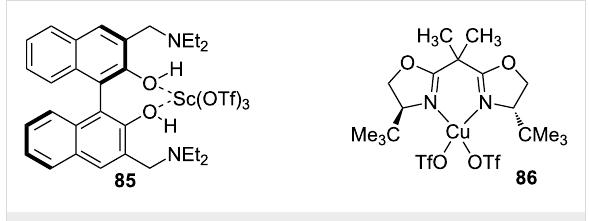
Figure 6: Chiral Lewis acid complexes used in the Mukaiyama–Michael addition of α , β -unsaturated